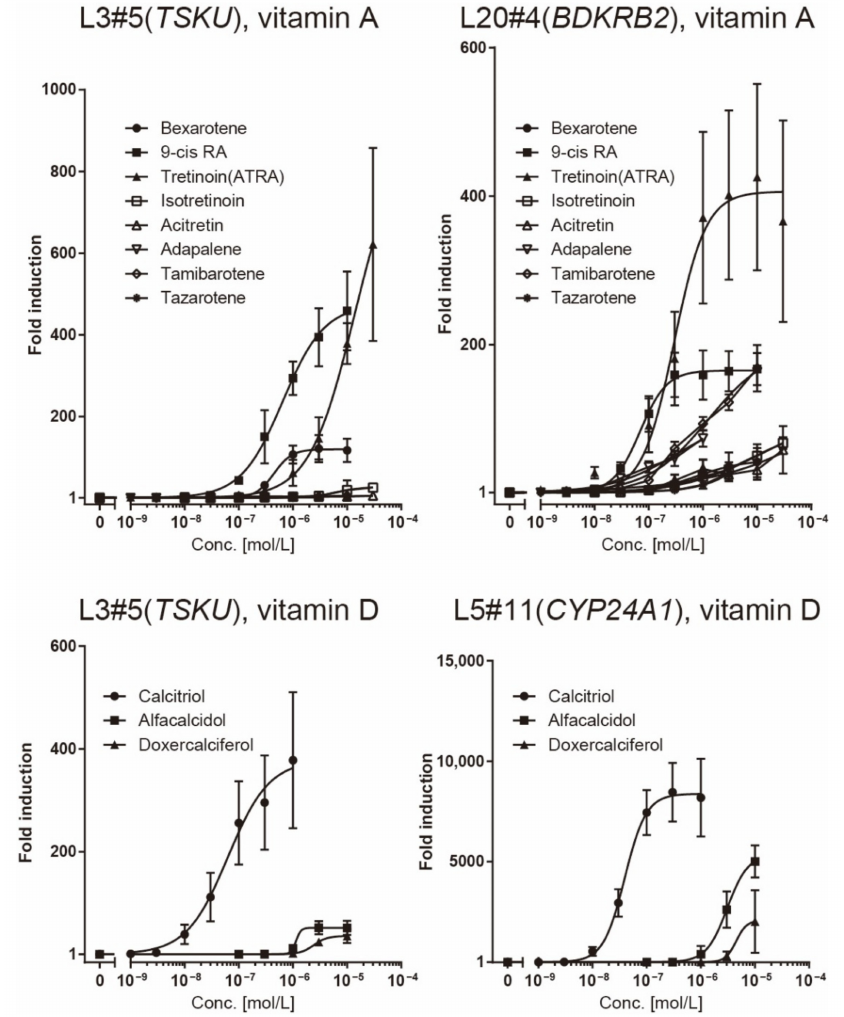
Figure 5. Comparison of the responsiveness of reporter cells to vitamin reagents. The data presented in Figure 4 was redrawn for comparison of responsiveness between the reagents in each reporter cell.